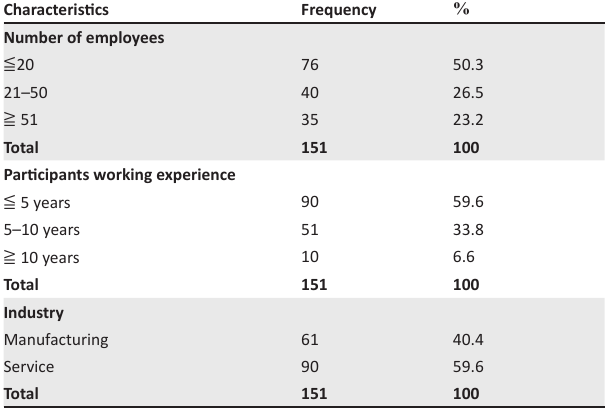
TABLE 1: Sample profile